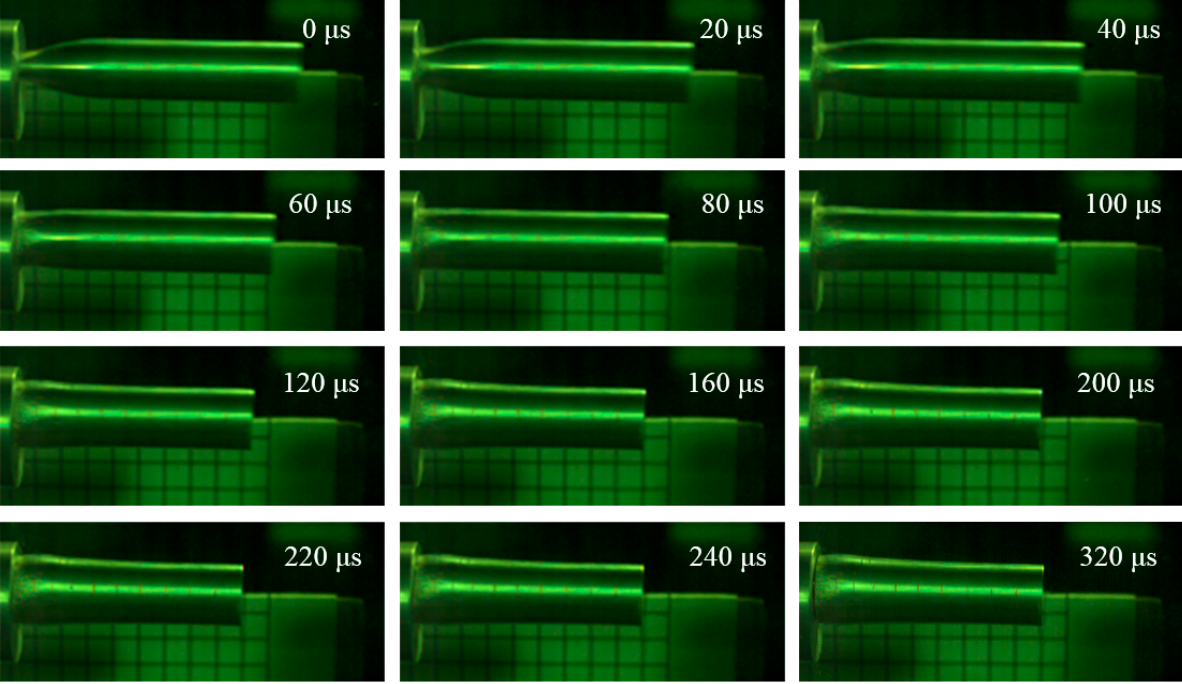
Figure 8. Series of high-speed photographs of the Taylor impact of the hemispherical projectile (178 m/s).